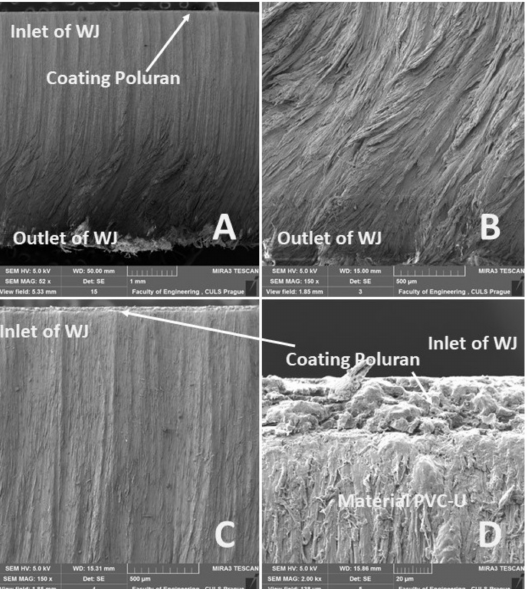
Figure 23. Cutting view of the tested PVC-U + POLURAN, WJ technology, cutting head traverse speed 1000 mm · min − 1 : ( A ) overall cut (MAG 52 × ); ( B ) detailed view of the outlet of WJ (MAG 150 × ); ( C ) detailed view of the inlet of WJ (MAG 500 × ); ( D ) detailed view of the interface of POLURAN coating and PVC-U material (2000 ×